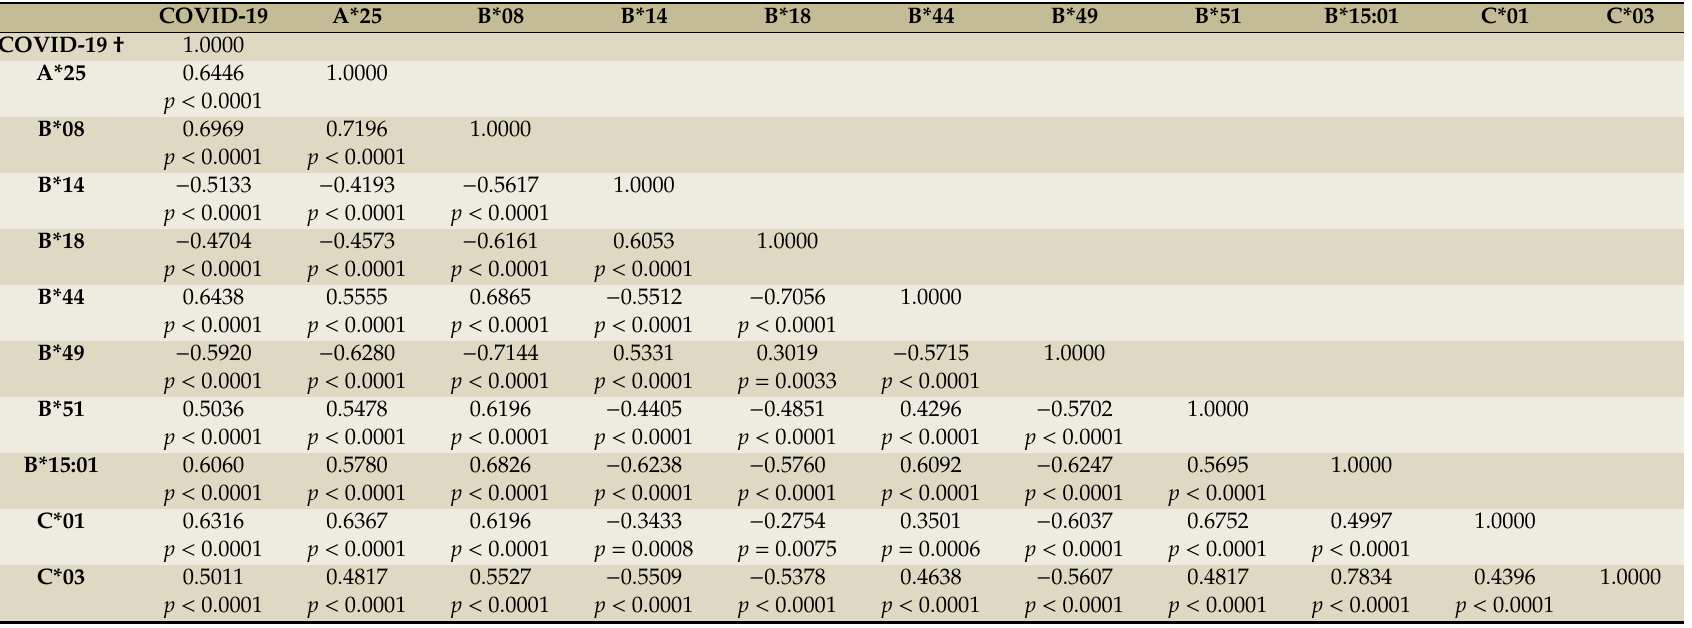
Table 1. – Matrix of correlation (Pearson’s coe ffi cient and p -value) between COVID-19 incidence rate and